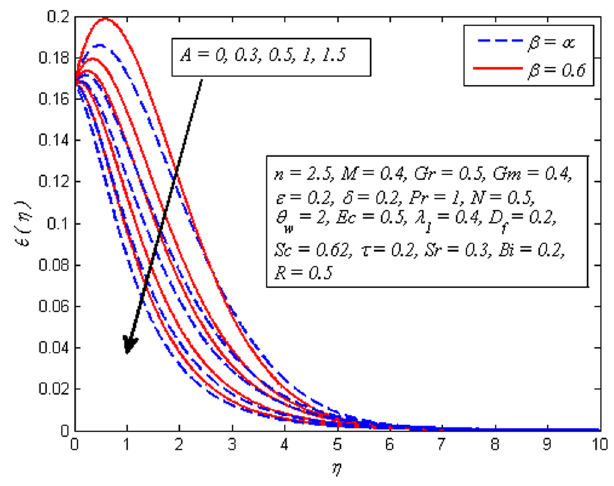
Figure 10. Effect of A on temperature for two different values of β .